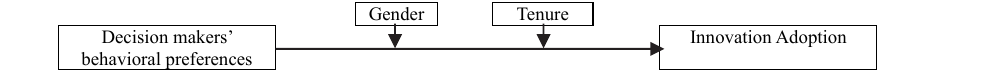
Fig. 3. The conceptual model of the effect of moderation variables on the relationship of decision-makers’ behavioral preferences and innovations